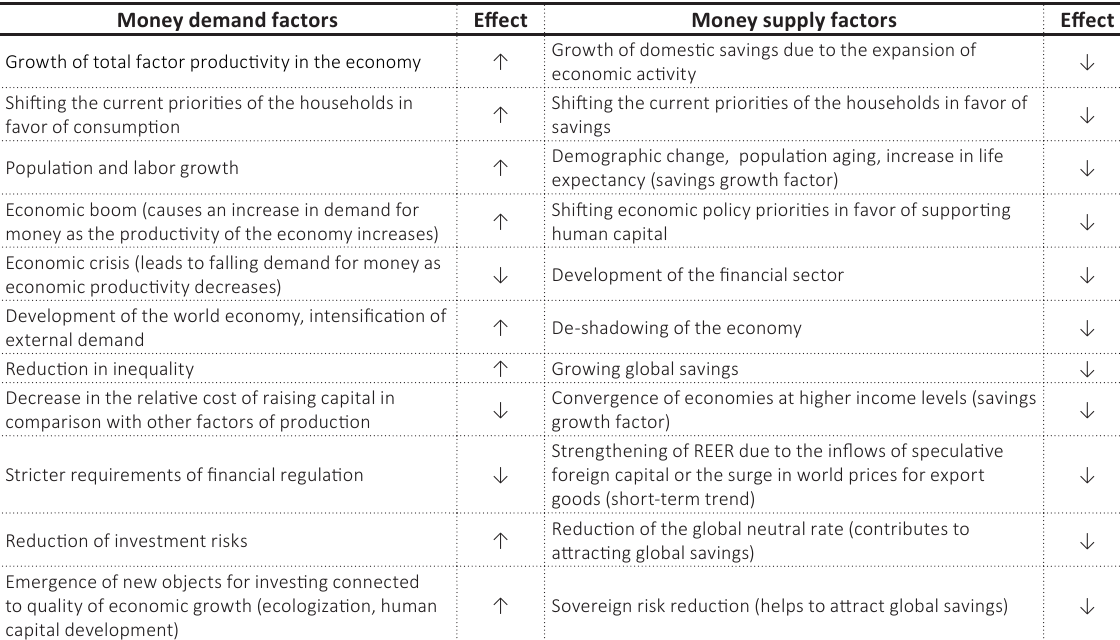
Table 2. Some factors of changes in the neutral interest rate and the type of their